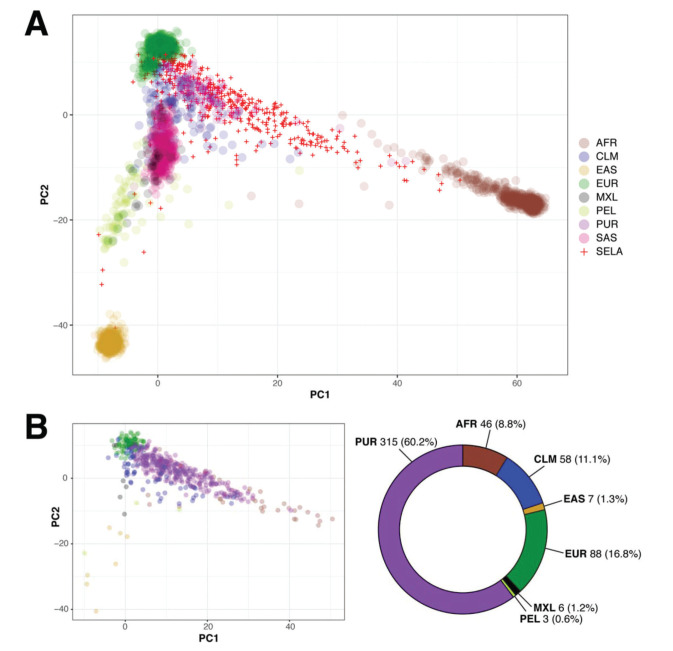
Panel A: biplot (x-axis: PC1, y-axis: PC2) showing the overlap between 1000 Genomes (colored circles) and SELAdb individuals (red crosses). In this representation, the AMR population is split according to its subpopulations, including Colombians (CLM), Mexicans of Los Angeles (MXL), Peruvians of Lima (PEL), and Puerto Ricans (PUR). Panel B: Neural network classification of SELAdb individuals using the 1000 Genomes as a training set. Consistent with the distribution of SELAdb individuals in Panel A, most SELAdb individuals classify as PUR.